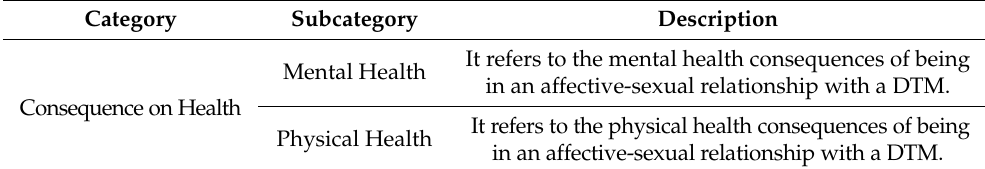
Table 1. Category and subcategories of Communicative Content Analysis.